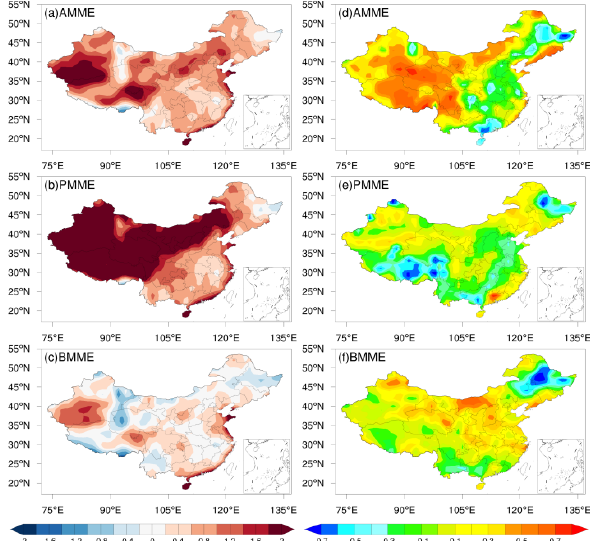
Figure 7. Spatial distribution of ( a – c ) absolute bias (m·s − 1 ) and ( d – f ) temporal correlation for AMME, PMME, and BMME between the observations and CMIP6 simulations of annual NWS over China.